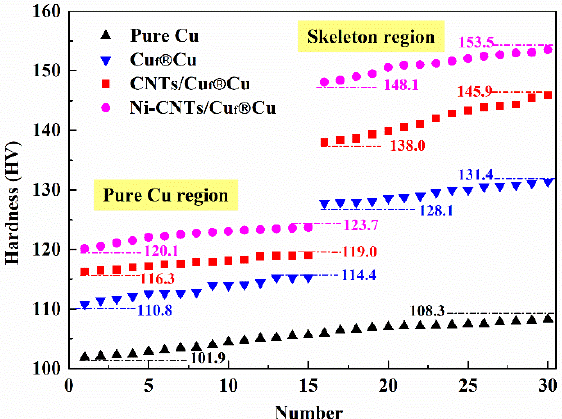
Figure 6. Vickers microhardness of pure Cu and composite samples.